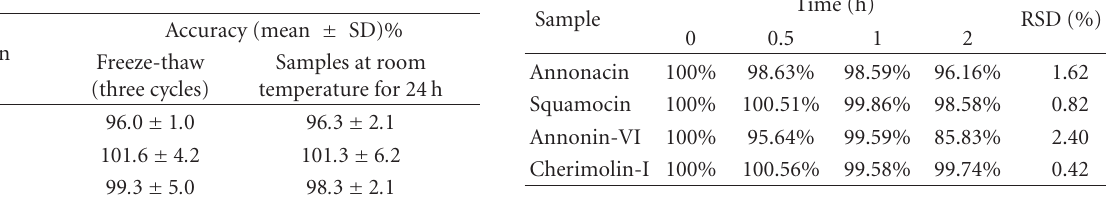
Table 1: Stability test of ACGs during the storing and preparation procedures.